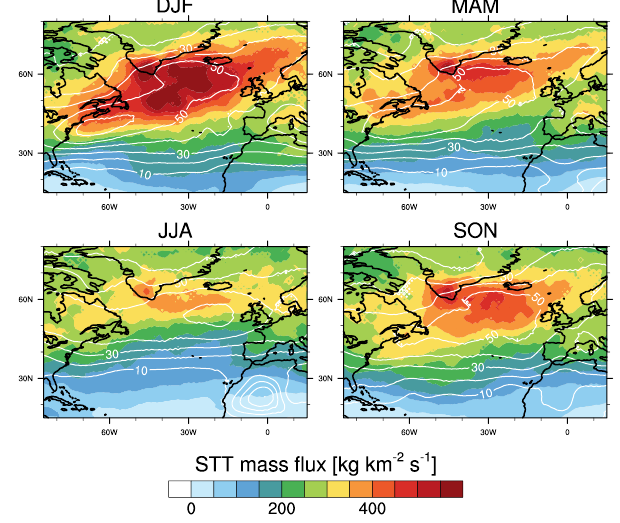
Figure 5. Seasonally averaged STT mass flux (kgm − 2 s − 1 ) for 1979–2011. The white contours indicate the fraction of the mass flux that is associated with cyclones (in %, contour interval 10%).